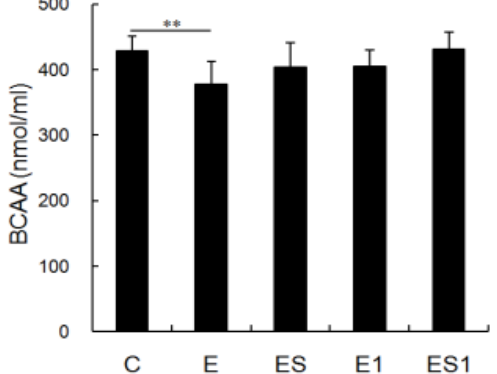
Figure 2. Effects of strenuous exercise and branched-chain amino acid (BCAA) supplementation on the serum BCAA concentration. BCAA levels in the serum were measured using high-performance liquid chromatography (HPLC). Data are means ± Standard Deviation (SD). ** p < 0.01. (C) Control; (E) Exercise; (E1) Exercise with 1 week to recover; (ES) Exercise + Supplementation; ES1) Exercise + Supplementation with 1 week to recover; the following are same.